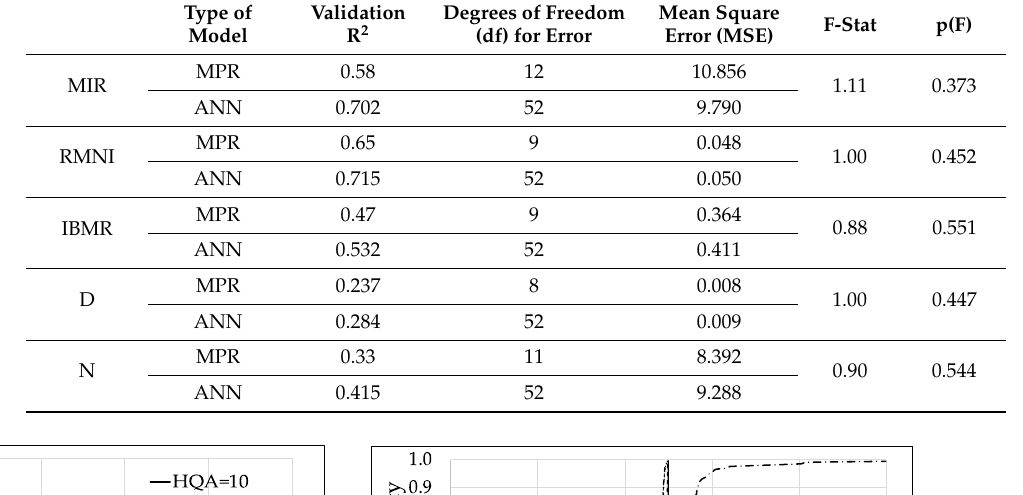
Table 4. Comparing MSE for MPR and ANN models using the F-statistic (ANN data from previous work [18]).